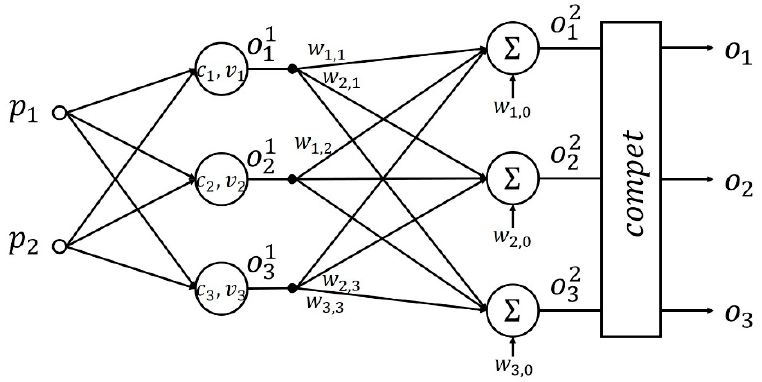
Figure 5. SL-Scheme for the example.